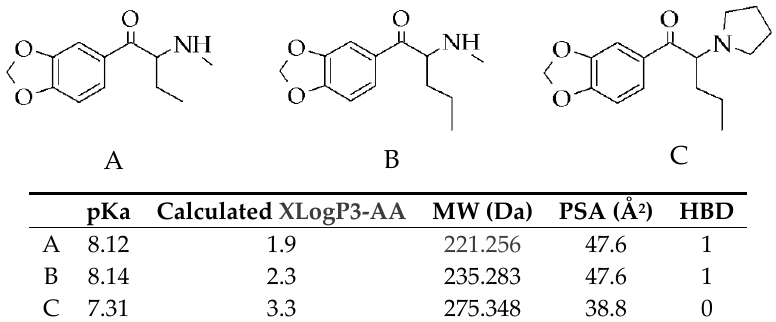
Figure 1. Chemical structures of three synthetic cathinones (SCs): ( A ) butylone, ( B ) pentylone, and ( C ) 3,4-Methylenedioxypyrovalerone (MDPV). Table: Estimated pKa values (measure of ionization) calculated using MarvinSketch software (https: // chemicalize.com / ), XLogP3-AA (measure of lipophilicity), molecular weight (MW), polar surface area (PSA), and hydrogen bond donors (HBD) of ( A